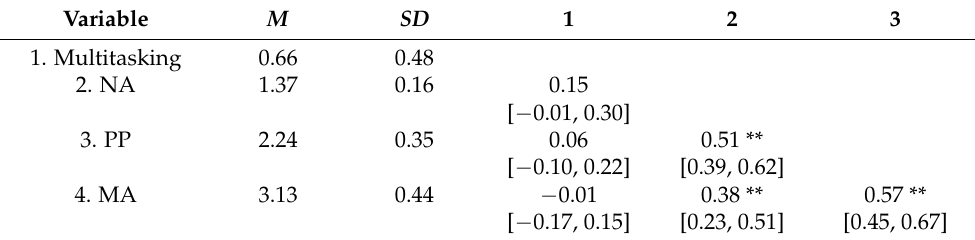
Table 1. Means, standard deviations, and correlations with confidence intervals.